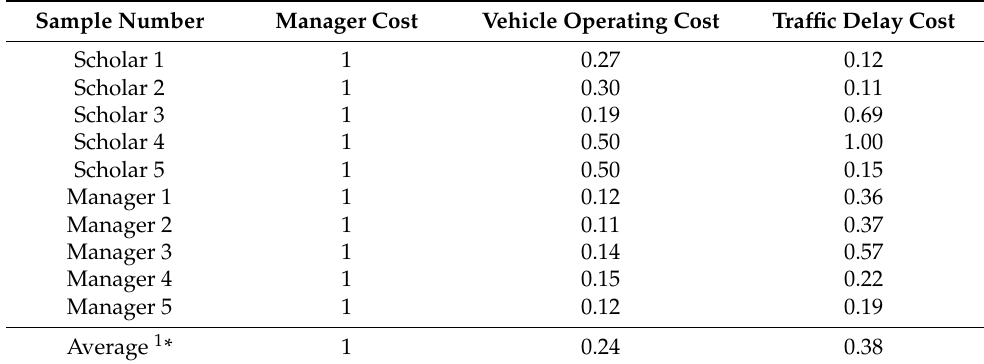
Table 7. The conversion factors of user